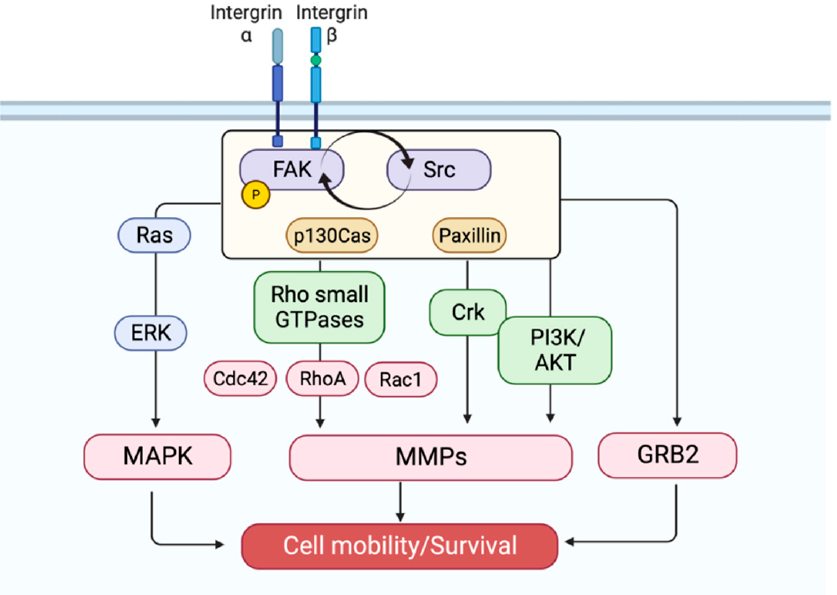
Figure 1. Overview of FAK regulation in focal contacts. The activation of FAK in response to integrin engagement causes the formation of phosphotyrosine-binding regions such as SH2 and SH3 domains for a number of molecules. FAK contains at least six tyrosine phosphorylation sites, including Tyr397, Tyr407, Tyr576, Tyr577, Tyr861, and Tyr925. Of these sites, the best characterized one is Tyr397, which creates an affinity docking site that can be particularly recognized by the SH2 domain-containing protein Src kinase. The high-affinity binding of FAK with Src provides multiple phosphorylation sites or structural motifs for substrate molecules, such as p130Cas (a Crk-associated substrate) and paxillin, which lead to dynamic regulation of the actin cytoskeleton and focal adhesions. Given the fact that FAK, in response to integrins, clusters with other transmittal receptors that bind to ECMs, it can integrate signals and mediate efficient cellular processes, including cell survival, motility, invasion, and angiogenesis. MAPK, mitogen-activated protein kinase; MMPs, matrix metalloproteinases; GRB2, growth factor receptor-bound protein